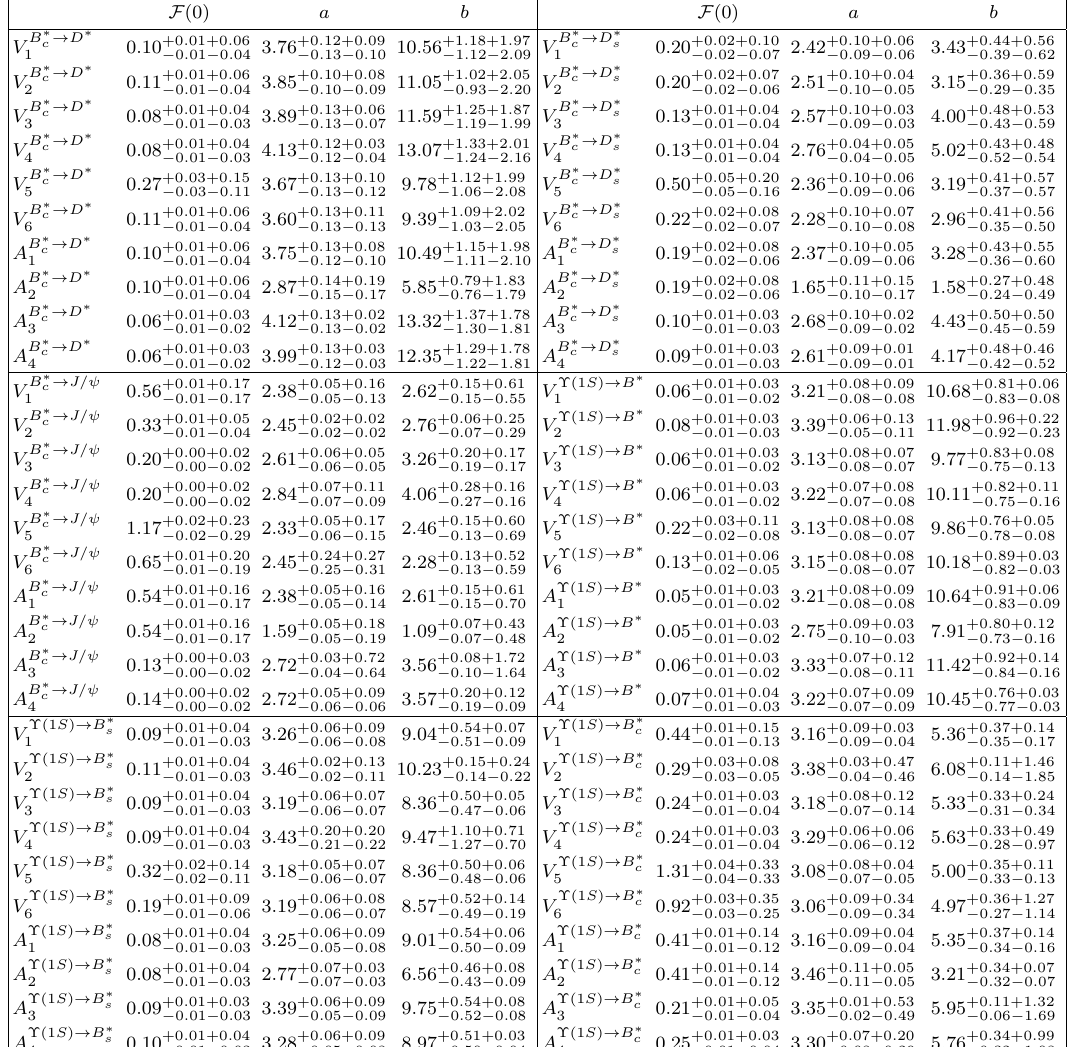
Table 10 . Same as table 6 except with the parameterization scheme given by eq. (4.15). The errors are due to parameters (cid:12) and quark masses only (cf. section 4 for a more complete discussion).